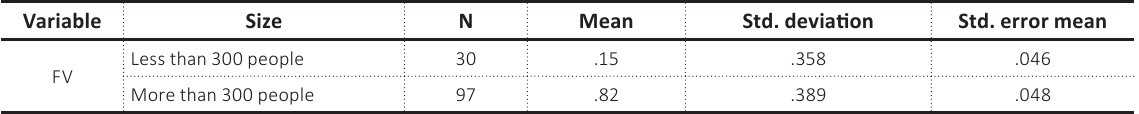
Table 1. Group statistics